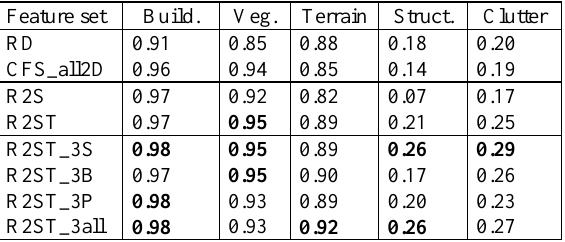
Table 5. Correctness of selected feature sets for buildings (Build.), vegetation (Veg.), terrain, structures (Struct.) and clutter Feature set